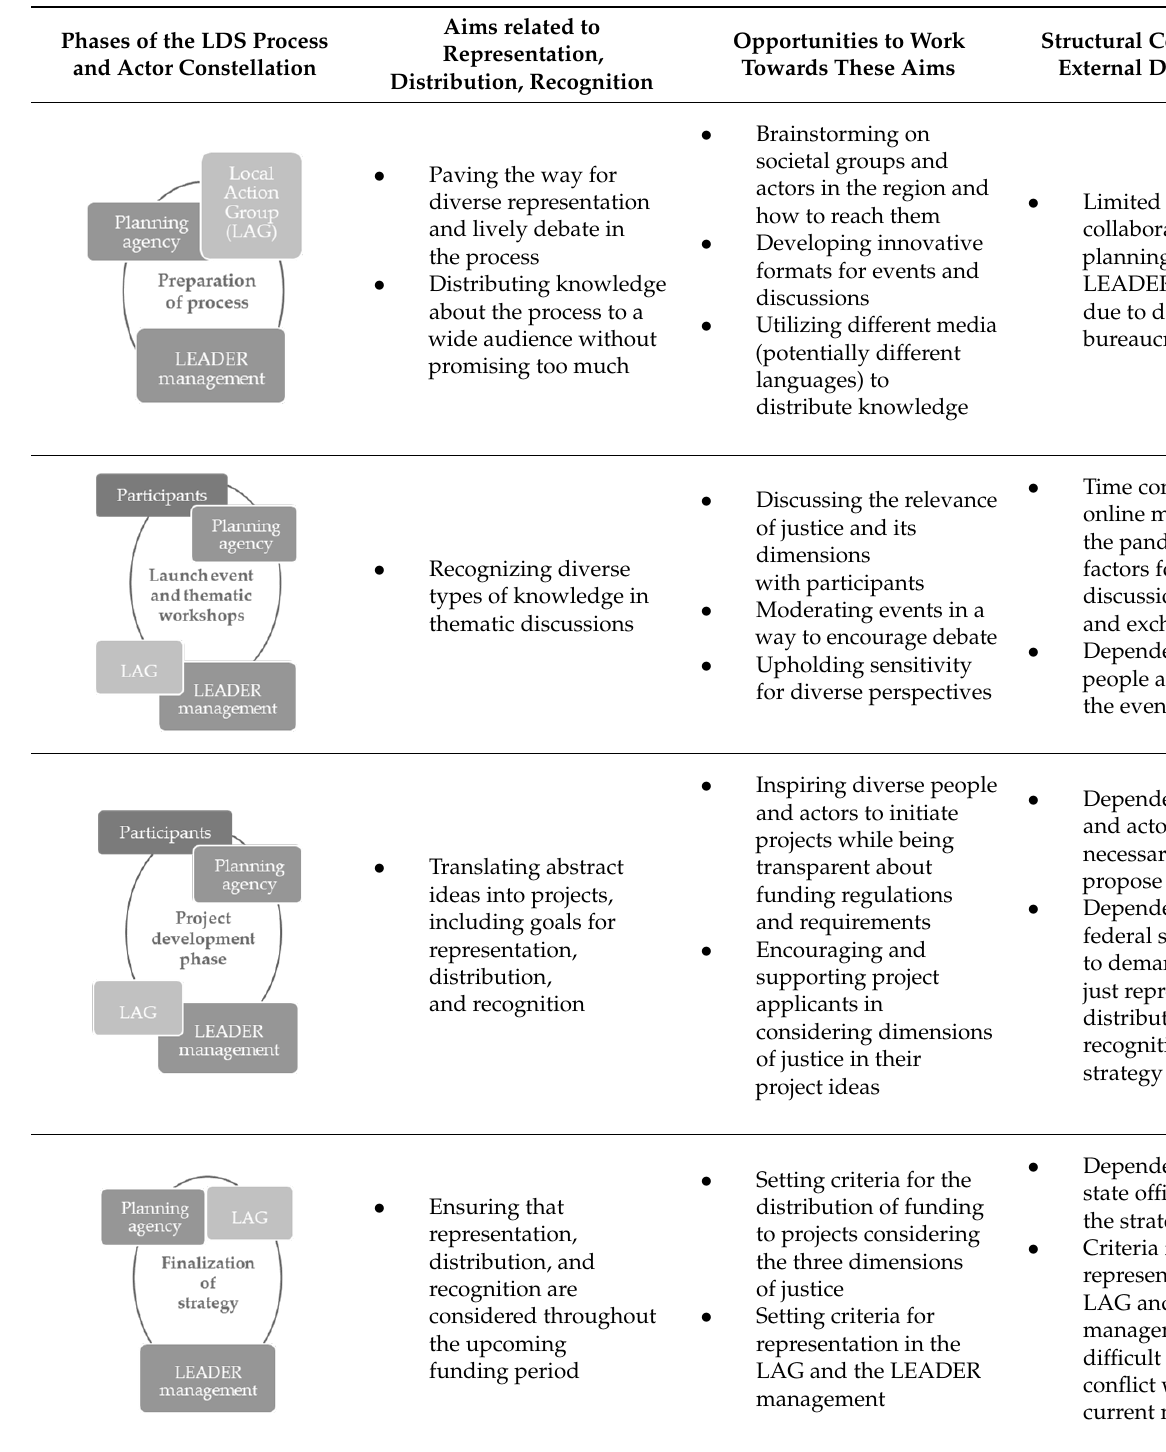
Table 2. A summary of opportunities and constraints in working towards aims related to representa- tion, distribution, and recognition in the different phases of the LDS process, as addressed by actors in the analyzed case study